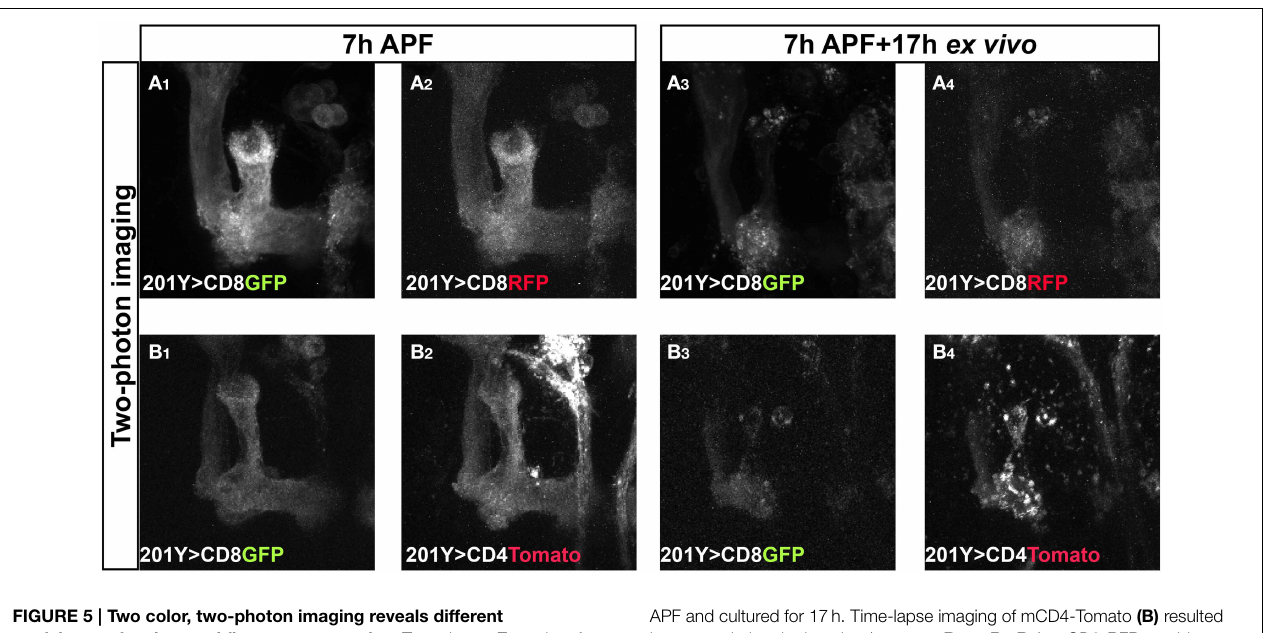
APF and cultured for 17h. Time-lapse imaging of mCD4-Tomato (B) resulted in puncta during the imaging (compare B 4 to B 2 , B 3 ). mCD8-RFP provides good anatomical representation throughout the imaging similar to mCD8-GFP (compare A 4 to A 2 ,A 3 ). See also Supplemental Movies 5,